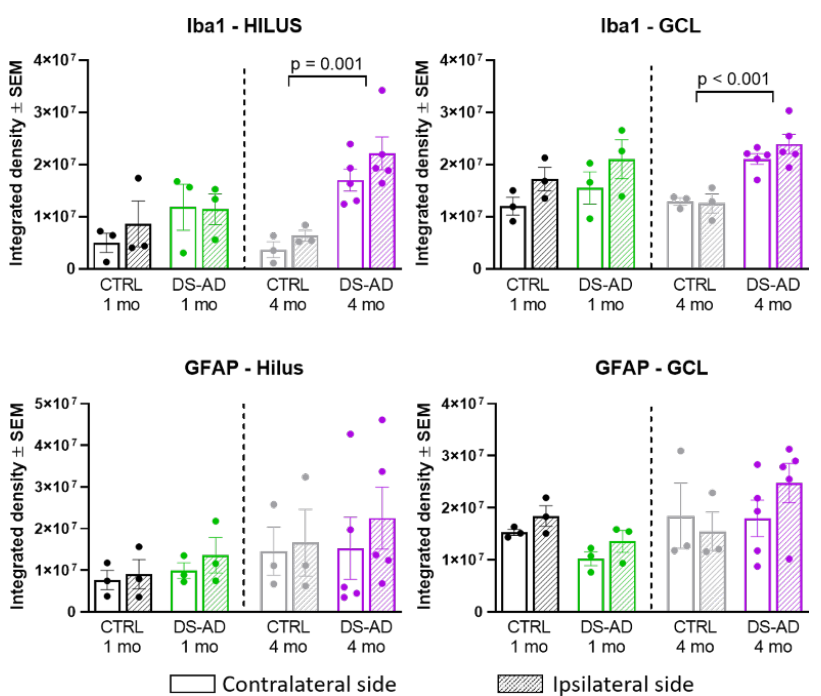
Figure 8. Densitometry for Iba1 and GFAP showed increased glial activation in mice injected with the DS-AD NDEVs compared to controls. Density measurements for Iba1, but not GFAP, were significantly elevated 4 months after DS-AD injection compared to controls ( p < 0.001).